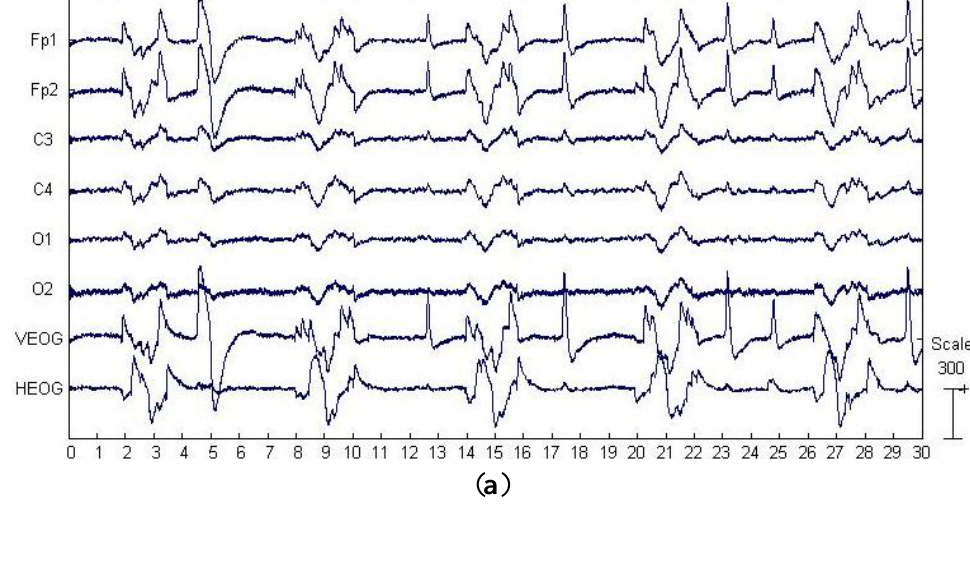
Figure 4. Results of EOG artifact removal on the real EEG data. ( a ) The raw EEG recordings with eye movement and blink artifacts, as well as the simultaneous recordings of the EOG signals; ( b ) Components separated by SSA; ( c ) Components separated by SOBI; ( d ) Components separated by ICA; ( e ) IMFs decomposed by applying EMD on the last two components in (b); ( f ) The raw EEG recording and the corrected EEG signals by each methods on channel Fp1; ( g ) The zoomed artifacts-corrected signals in the artifact-free epoch on channel